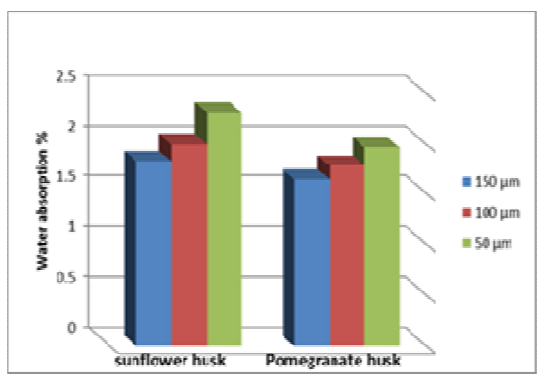
Fig. 13. Effect of sunflower husk and pomegranate husk grain size particles on water